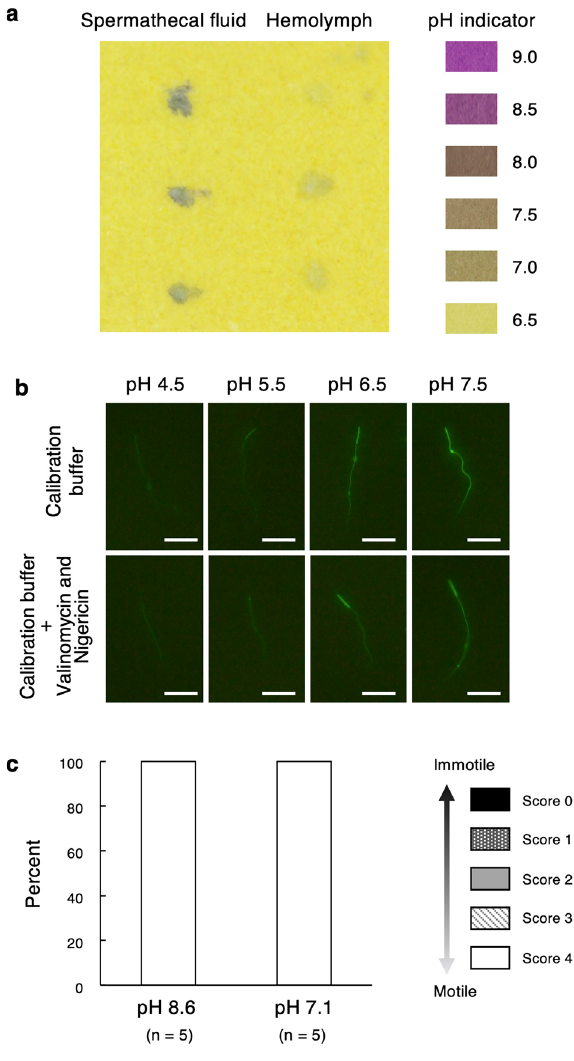
Figure 6. ( a ) pH of the spermathecal fluid and hemolymph. ( b ) Effect of extracellular fluid pH on intracellular pH of sperm. Fluorescence intensity of BCECF-loaded sperm exposed to various pH-calibrated buffers and those containing valinomycin and nigericin (to equilibrate the pH inside and outside cells). Scale bars indicate 20 µm. ( c ) Effect of pH mimicking spermathecal fluid (pH 8.6) and hemolymph (pH 7.1) on sperm